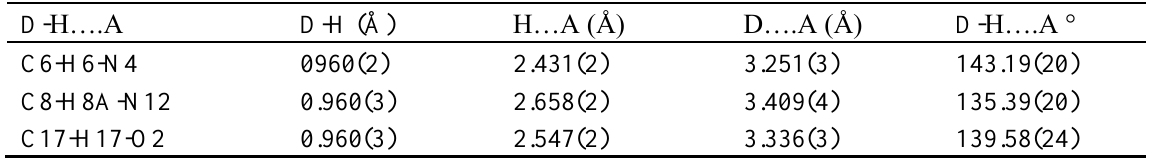
Table 3. Hydrogen bonding geometry of 2